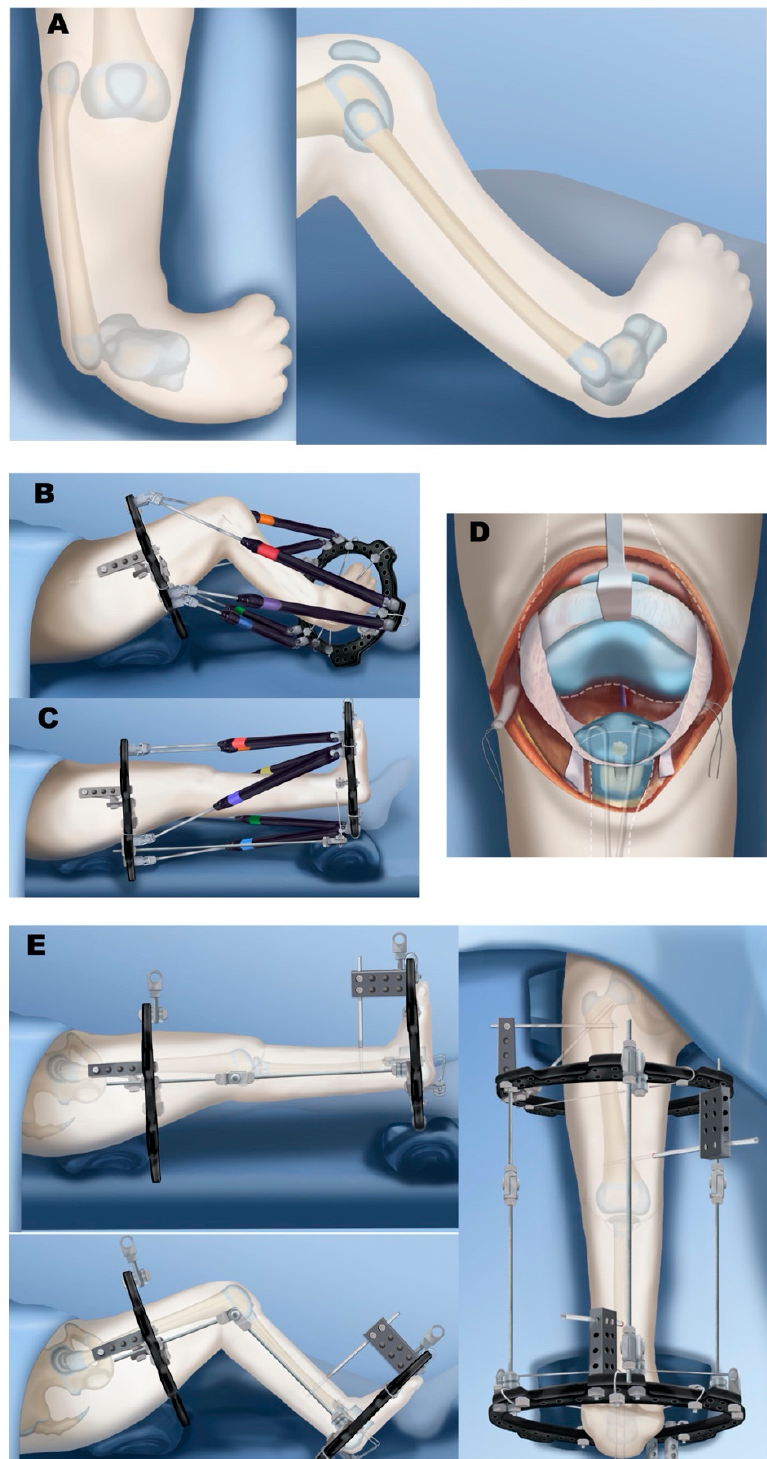
Figure 10. Treatment of Paley type 5A. ( A ) Complete aplasia of tibia, but patella and quadriceps are present. ( B ) External fixator placement for gradual fibula distraction and foot correction. ( C ) Knee flexion contracture corrected to straight position, preparing for physeal sparing patellar arthroplasty and physeal sparing talo-fibular fusion. ( D ) Paley-Weber patelloplasty converting the patella into a tibial plateau. ( E ) Hinged external fixator to protect arthroplasty but allow knee motion.